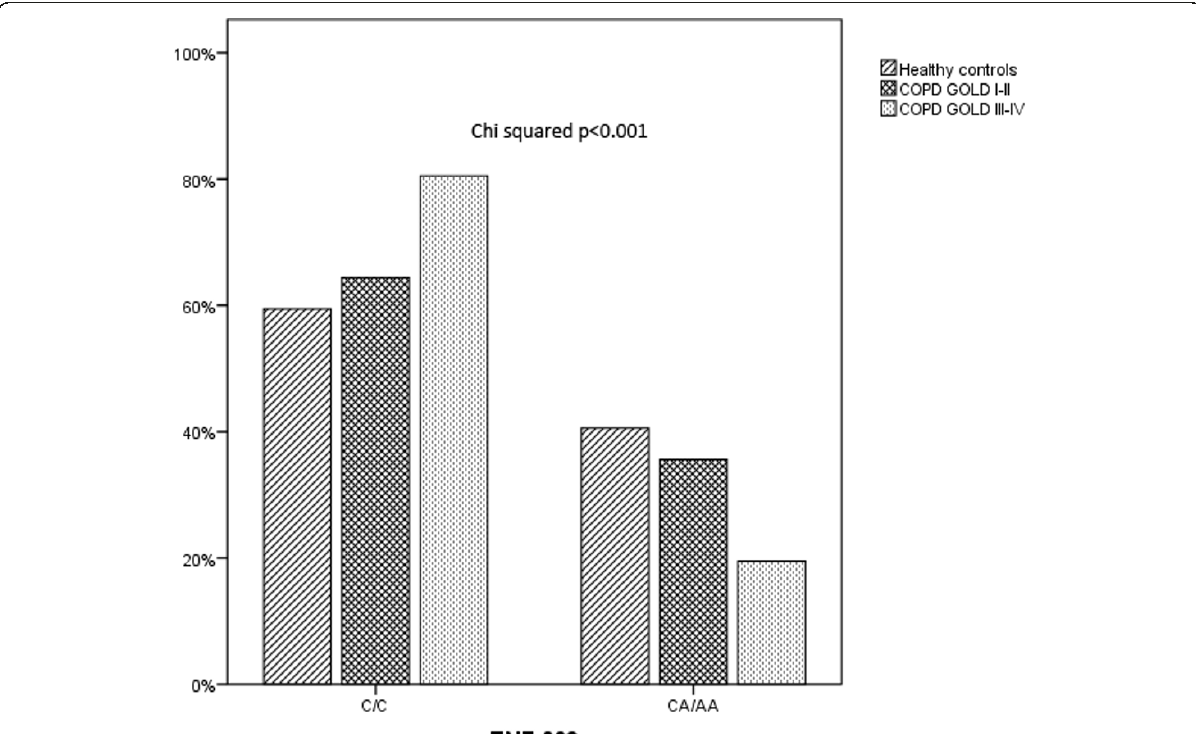
Figure 2 Frequency distribution of the TNFA -863 CC and CA+AA genotypes (dominant model) in three groups: healthy control subjects, GOLD I-II and GOLD III-IV COPD patients